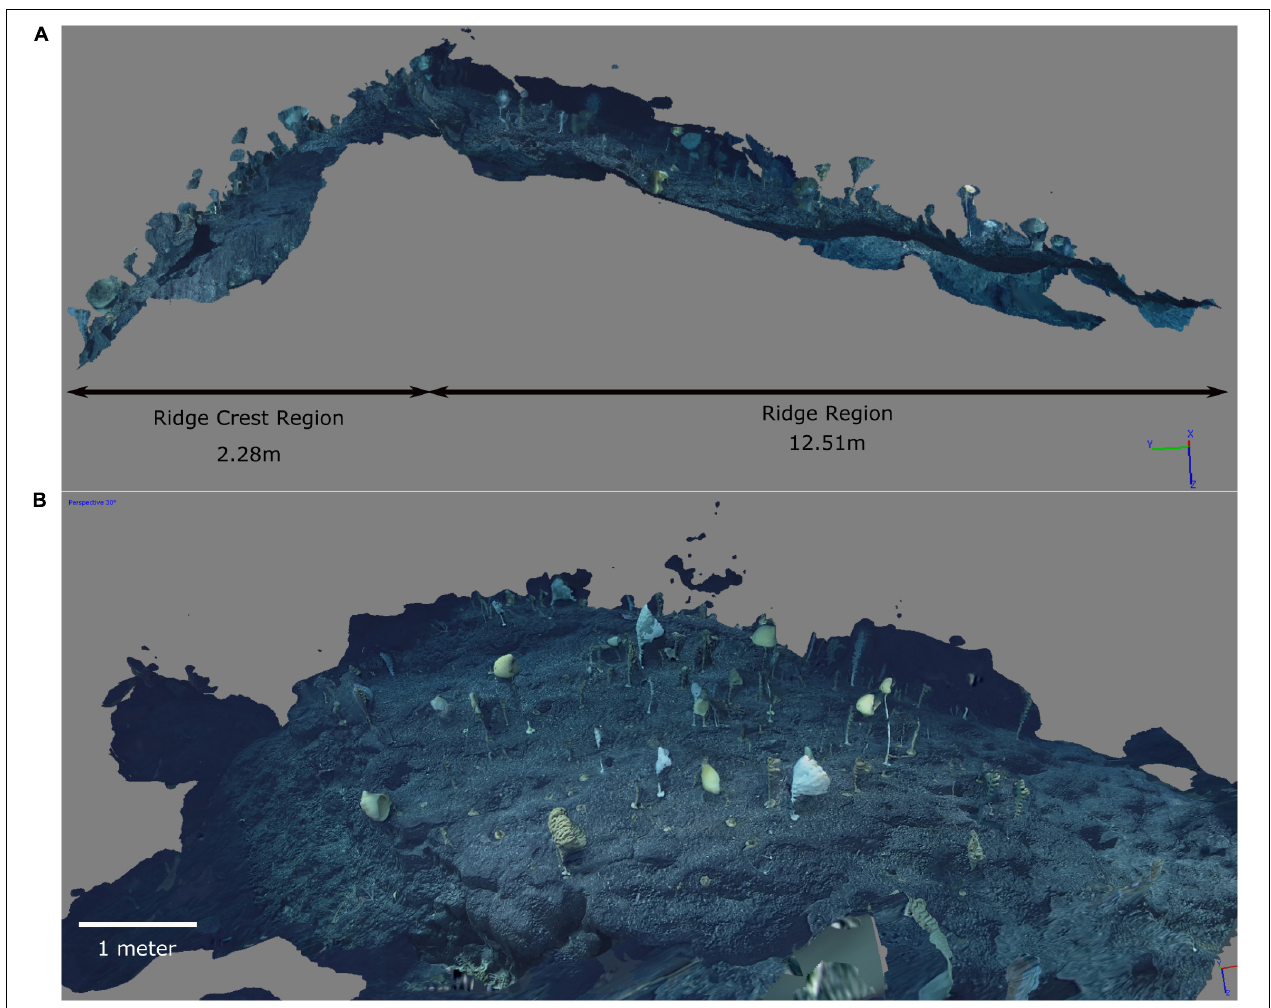
FIGURE 2 | Screenshots of the 3D reconstruction. (A) Side view showing the two different areas with the Ridge Crest area on the left and Ridge area on the right. (B) A closer view of the Ridge Crest community. The dark blue areas above the community and rising to the left and right are artifacts of the photogrammetry where frames included a lot of the farground. The substrate beyond the edge of the ridge to the right and left has good resolution, and so the edge of the community is clearly resolved. Note the badly resolved section at the bottom of the screenshot, where there wasn’t sufficient video coverage to reconstruct the substrate (which was sparsely